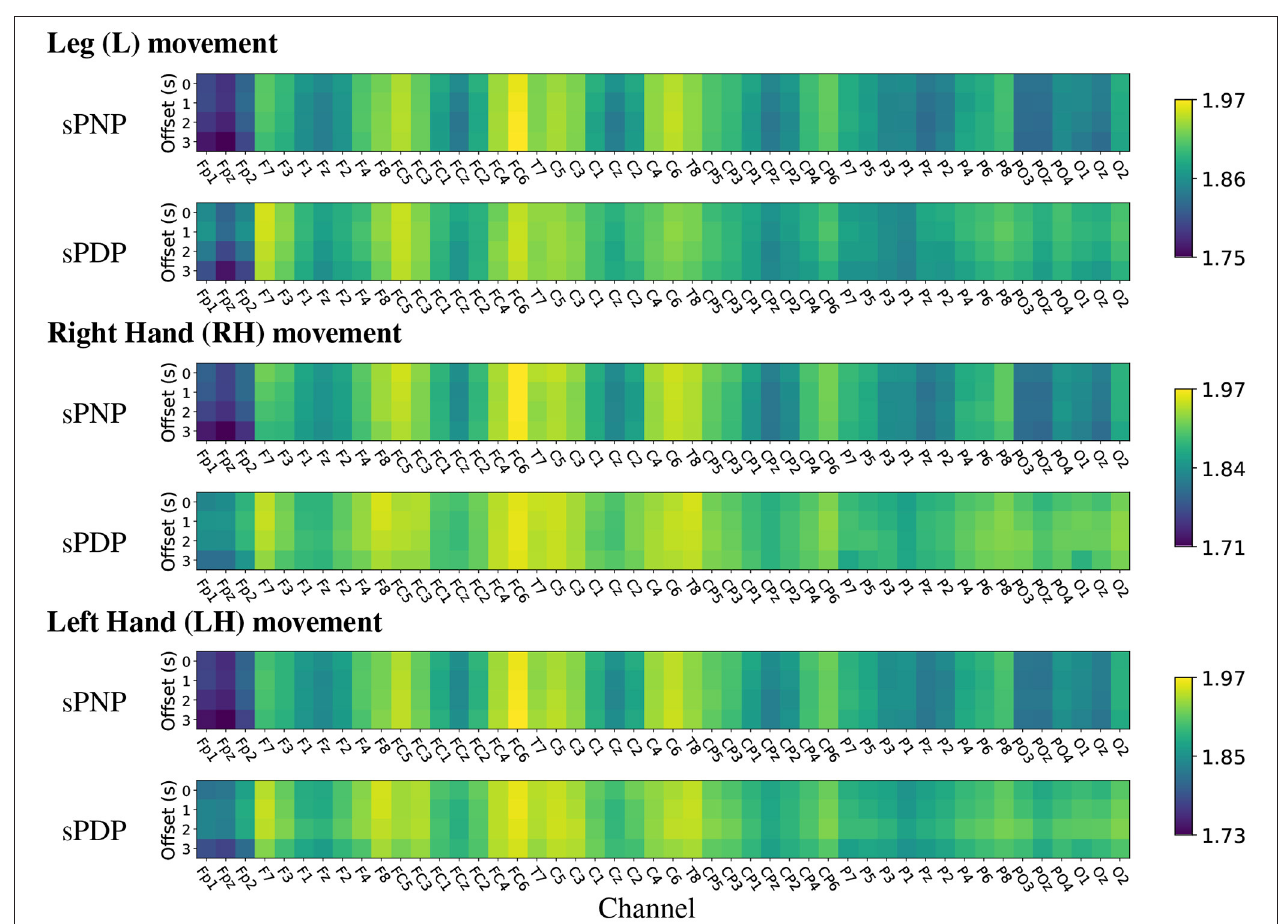
FIGURE 8 | (Dataset 2) Heat maps of group-wise mean Higuchi Fractal Dimension features extracted from EEG signals recorded during movement imagination from participants with subacute SCI that did not developed pain (sPNP) and participants with subacute SCI that later developed pain (sPDP). Colours represent low (blue), medium (green), and high (yellow) mean HFD ordered by channel along the x-axis and by time offset along the